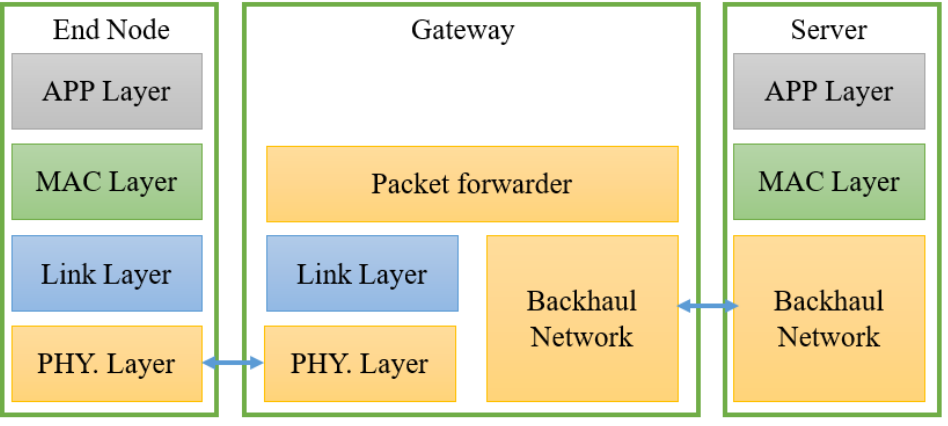
Figure 12. LoRa network stack.